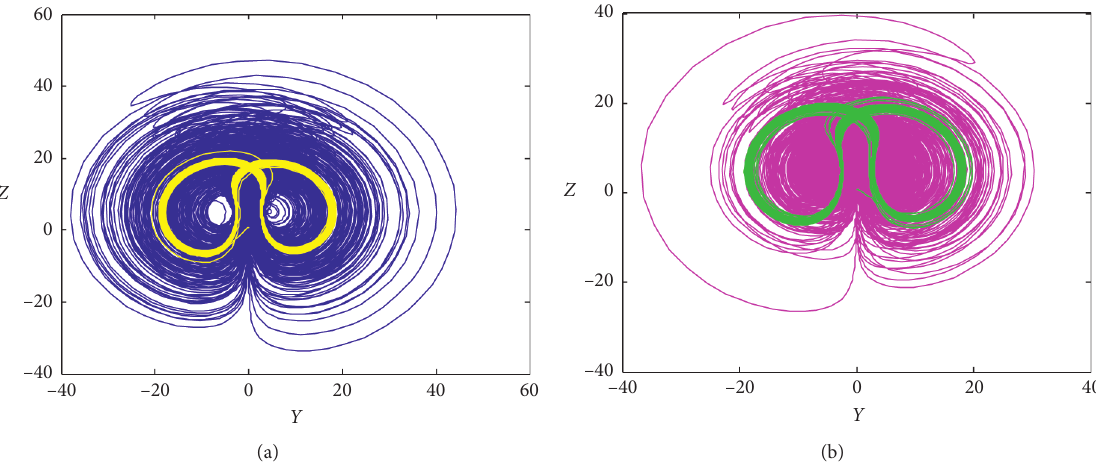
Figure 8: The phase portraits of coexisting hidden multiple attractors in the Y - Z plane with different negative and positive X (0) values. (a) X (0) �− 40 (blue), chaos; X (0) � − 15 (yellow), limit cycle. (b) X (0) � 19 (green), limit cycle; X (0) � 52 (magenta),